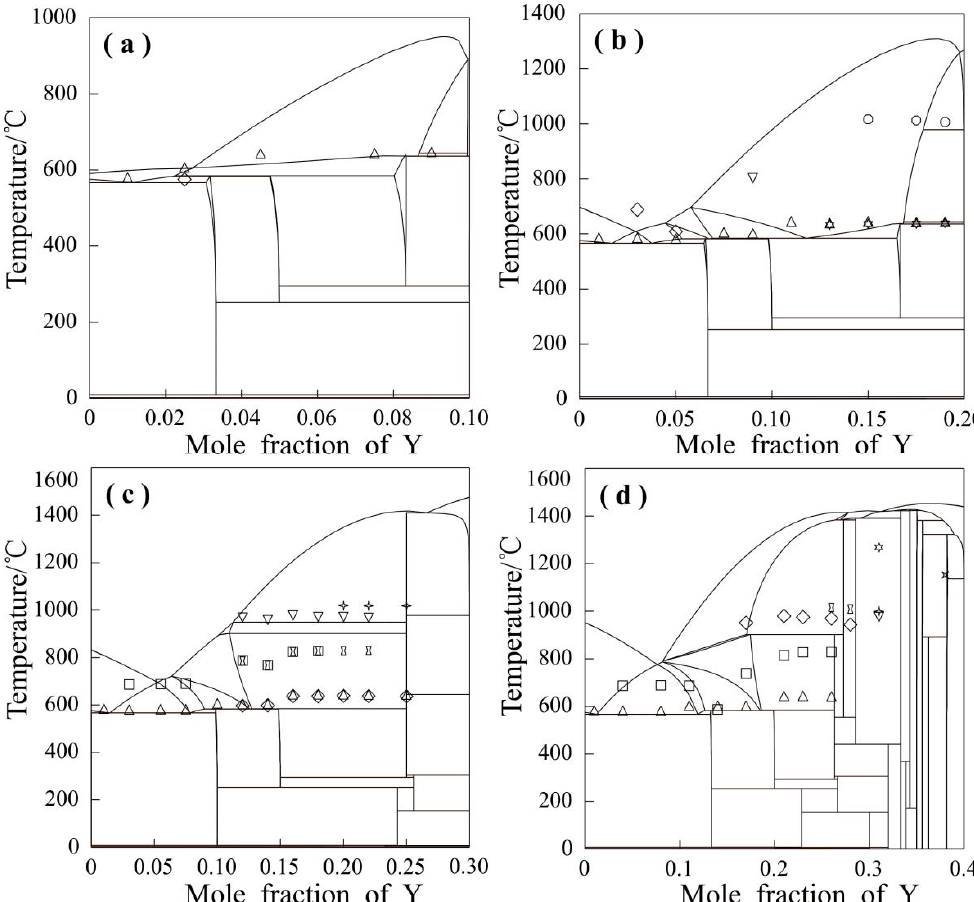
Figure 8. The computed vertical sections of Al–Si–Y system with the experimental data. ( a ) X(Al) = 90 at.%; ( b ) X(Al) = 80 at.%; ( c ) X(Al) = 70 at.%; ( d ) X(Al) = 60 at.%.